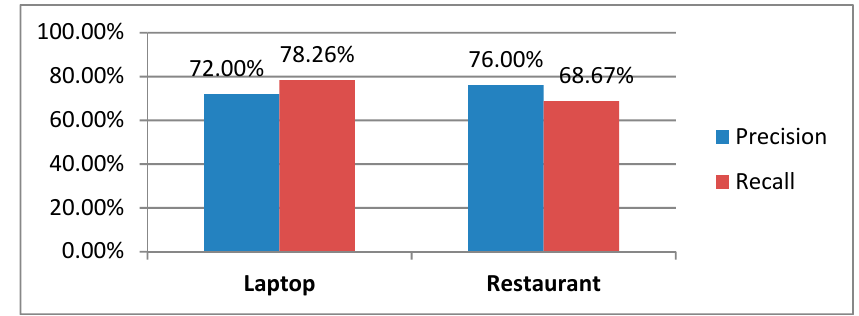
Figure 7. Precision and recall of the ASPER model.